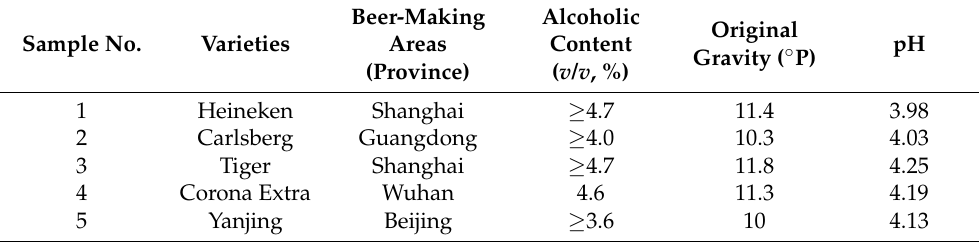
Table 10. Biogenic amine content of Chinese beer brands (adapted) [45]. Alcoholic Beer-Making Content Sample No. Varieties Areas ( v / v , %) (Province) Heineken